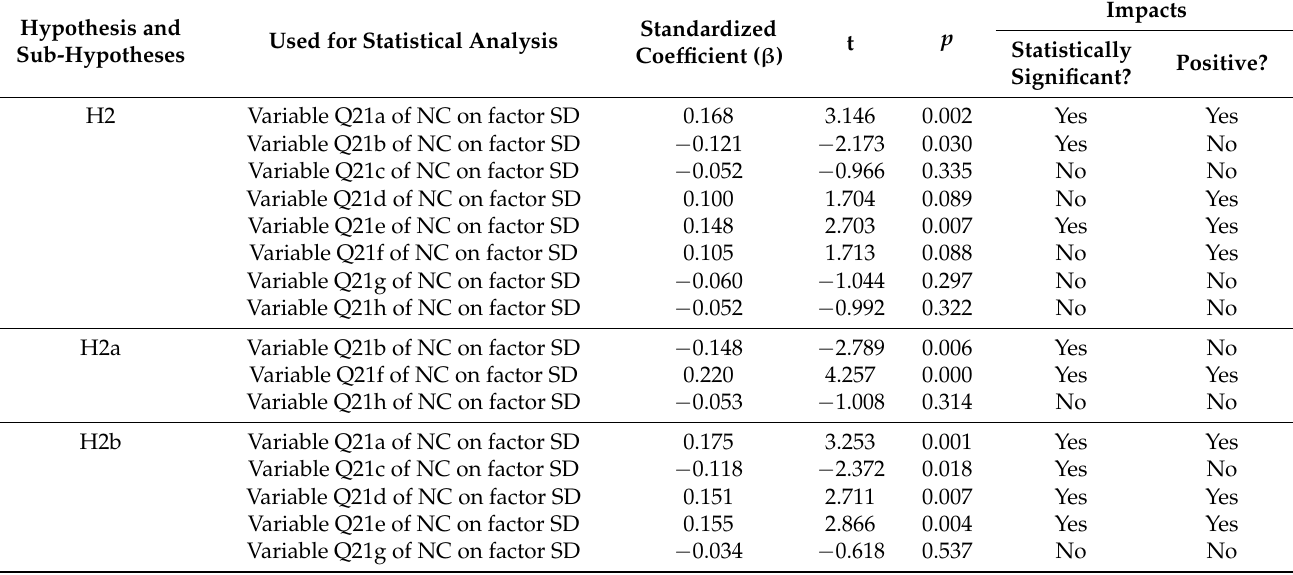
Table 3. Results of statistical analysis for hypothesis H2 and its